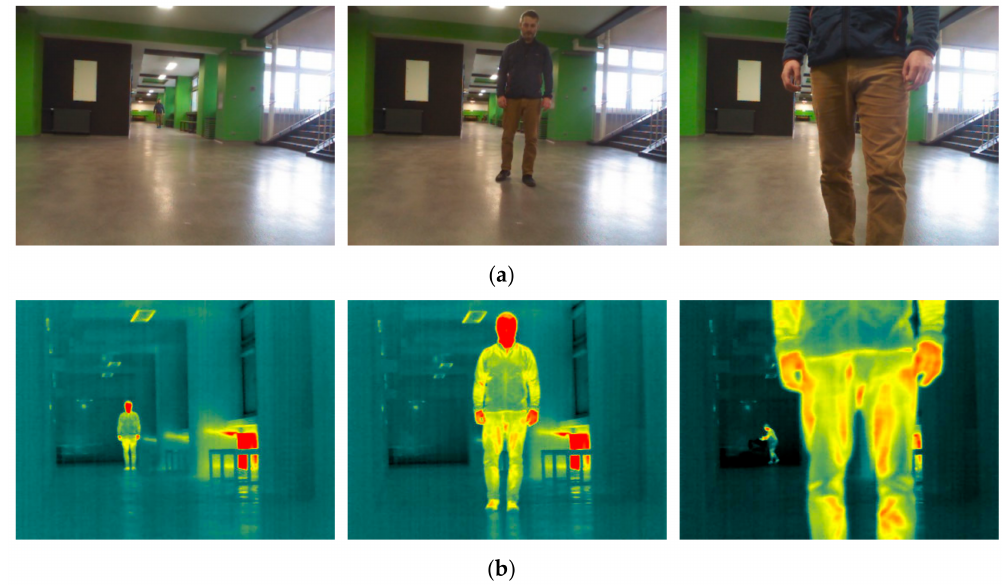
Figure 1. Series of sample acquired images: ( a ) vision images, and ( b ) infrared images.